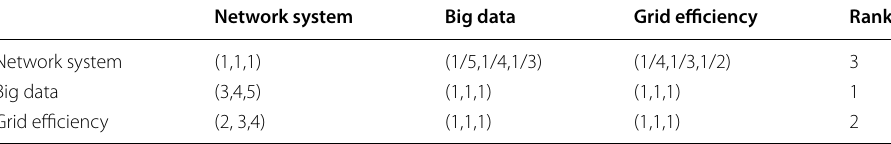
Table 1 The Fuzzy comparison matrix of main